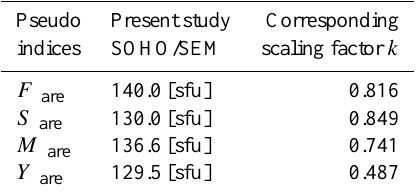
Figure 2. Neutral densities from GRACE measurements (black) and the empirical thermosphere model JB08 (red) using average daily indices in November 2004. Region 1 shows the sudden in- crease due to the X2.0 solar flare, whereas region 2 indicates the impact of an ICME a few hours later. Table 5. Estimated pseudo indices and the corresponding scale factor k for the X2.0 solar flare on 7 November 2004 using SOHO/SEM